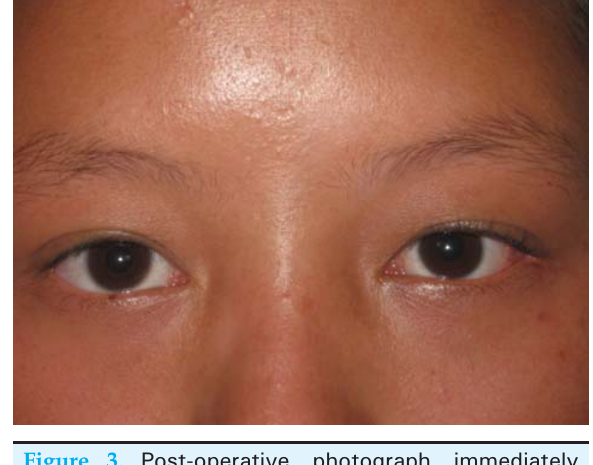
Figure 3. Post-operative photograph